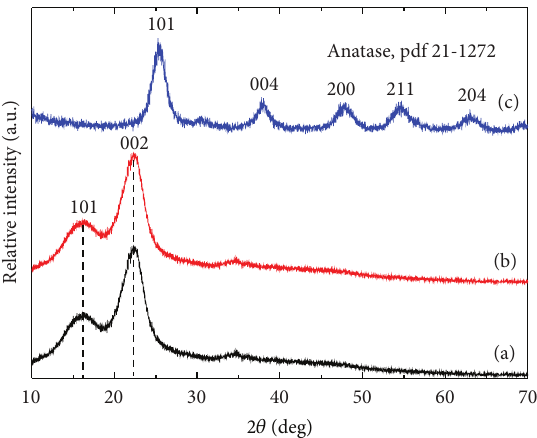
Figure 4: XRD patterns of (a) the original wood, (b) the wood coated by TiO 2 sol, and (c) wood-templated TiO 2